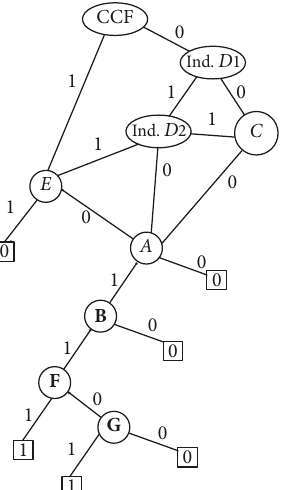
Figure 8: Example of combined BDD at the end state.